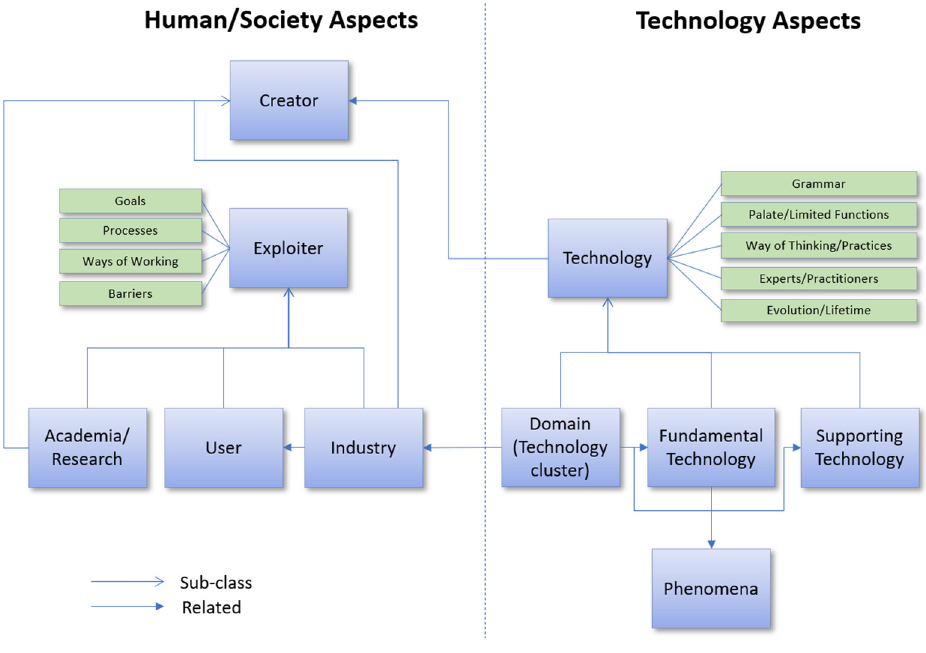
Figure 1. Arthur’s concept of the technology eco-system, Brackin et al. (2019) [16].